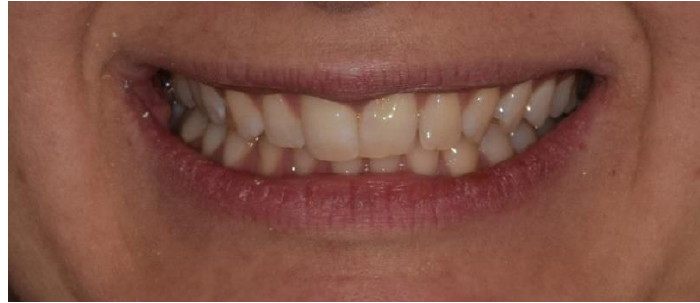
Figure 2. Deep bite with good exposure of the upper incisors.